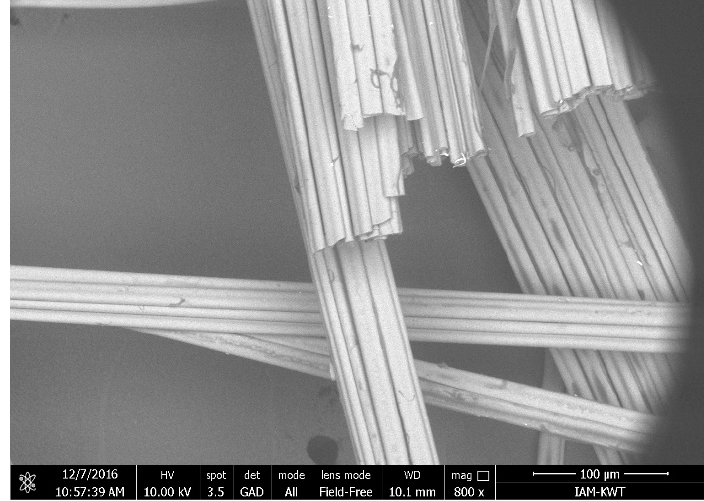
Figure 13. SEM image of fiber bundles with PVA sizing as delivered.